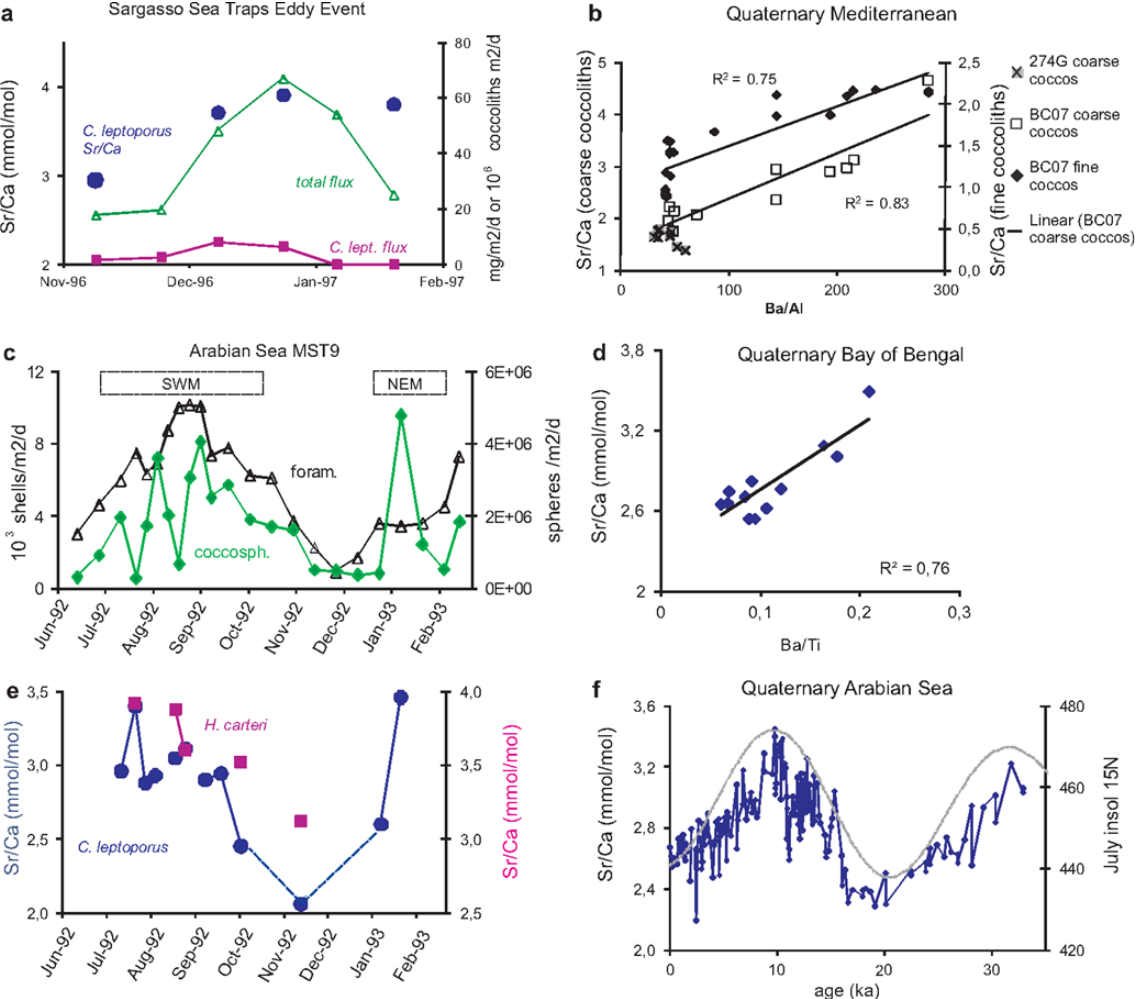
Fig. 2. Figures showing the relationship between coccolith Sr/Ca and coccolithophore productivity (from Stoll et al., 2007b). (a) Sr/Ca in picked C. leptoporus in Ocean Flux Program (OFP) sediment traps during increased export production (total and in C. leptoporus coccolith fluxes) triggered by passage of a mode water eddy. (b) Coccolith Sr/Ca plotted against Ba/Al productivity indicator. Fine coccolith fraction is dominated by E. huxleyi and coarse coccolith fraction by H. carteri (Eastern Mediterranean, Site BC07, ∼ 15Ka to present), including the early Holocene high productivity interval recorded in sapropel S1. Ba/Al is from nearby core GL94. Also shown are Sr/Ca in coarse H. carteri -dominated coccolith fraction from Western Mediterranean (274G) that features no sapropel or evidence of enhanced production in the early Holocene. (c, e) Sr/Ca in picked C. leptoporus and H. carteri in sediment traps from the Arabian Sea (MST9) covering a seasonal cycle of summer upwelling and high productivity during the southwest monsoon (SWM), and low productivity during the autumn intermonsoon, and high productivity during strong wind-triggered nutrient entrainment of the winter northeast monsoon (NEM). (d) Sr/Ca of picked C. leptoporus plotted against the Ba/Ti productivity indicator from Northern Bay of Bengal (RC12-343) from the penultimate glacial-interglacial transition. (f) Sr/Ca of C. leptoporus -dominated size fraction from Core 905, Somali Basin, Arabian Sea, and insolation for July at 15N (dashed gray line). Precessional maxima in summer insolation, and corresponding minima in winter insolation, drive a stronger summer upwelling and strong winter wind mixing, respectively, thereby boosting higher